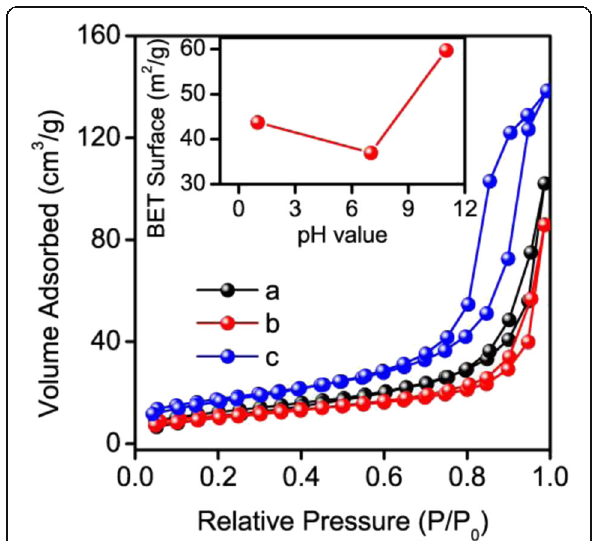
Fig. 7 Nitrogen adsorption-desorption isotherms of the as-prepared samples ( a SnNb 2 O 6 , b the mixed phases of SnNb 2 O 6 and Sn 2 Nb 2 O 7 , and c Sn 2 Nb 2 O 7 ). Inset figure shows the BET surface area as a function of pH value of the reaction